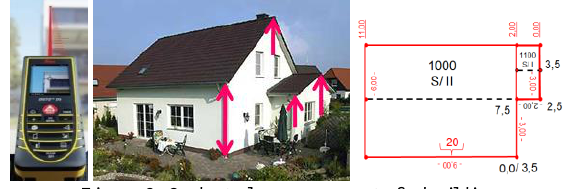
Figure 3. Cadastral measurement of a building